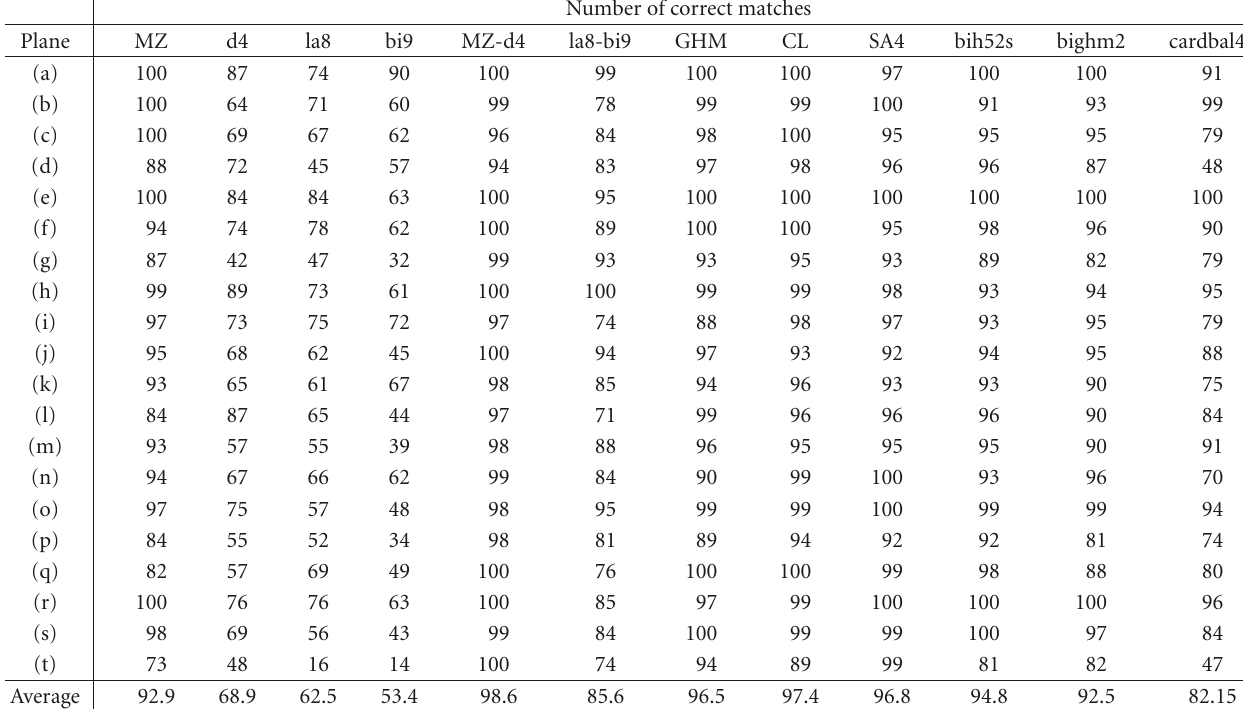
Table 1: Number of correctly matched poses of objects at 20dB with (multi)wavelet coe ffi